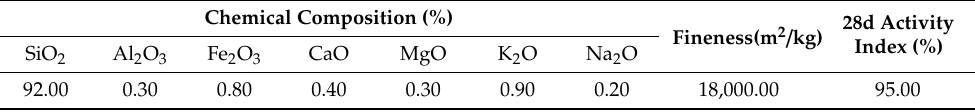
Figure 3. XRD diagram of silica fume.